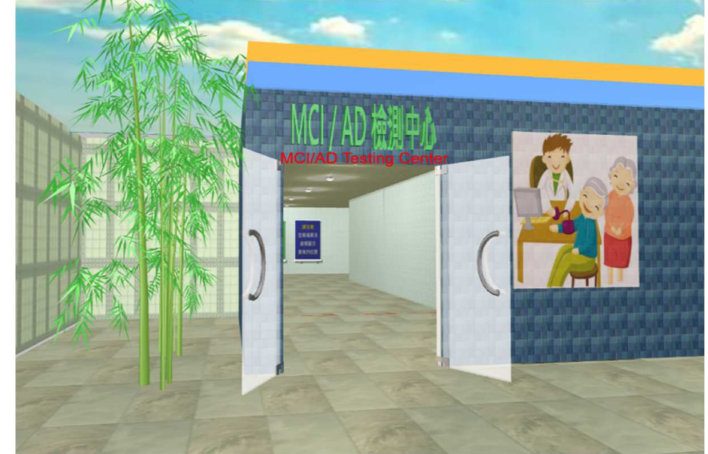
Figure 3. Startup screen of the